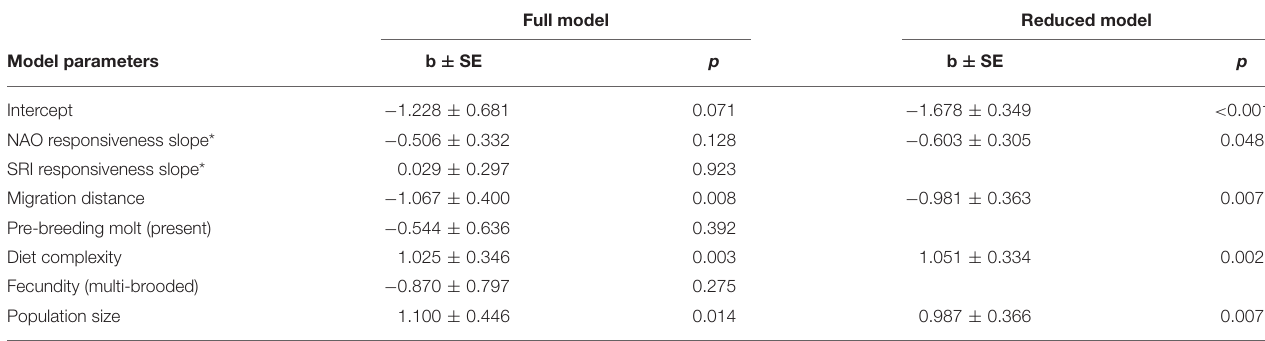
TABLE 1 | Phylogenetic logistic regression models predicting whether overwintering at the study site was detected in the species in more than 1 year during the study ( N = 107